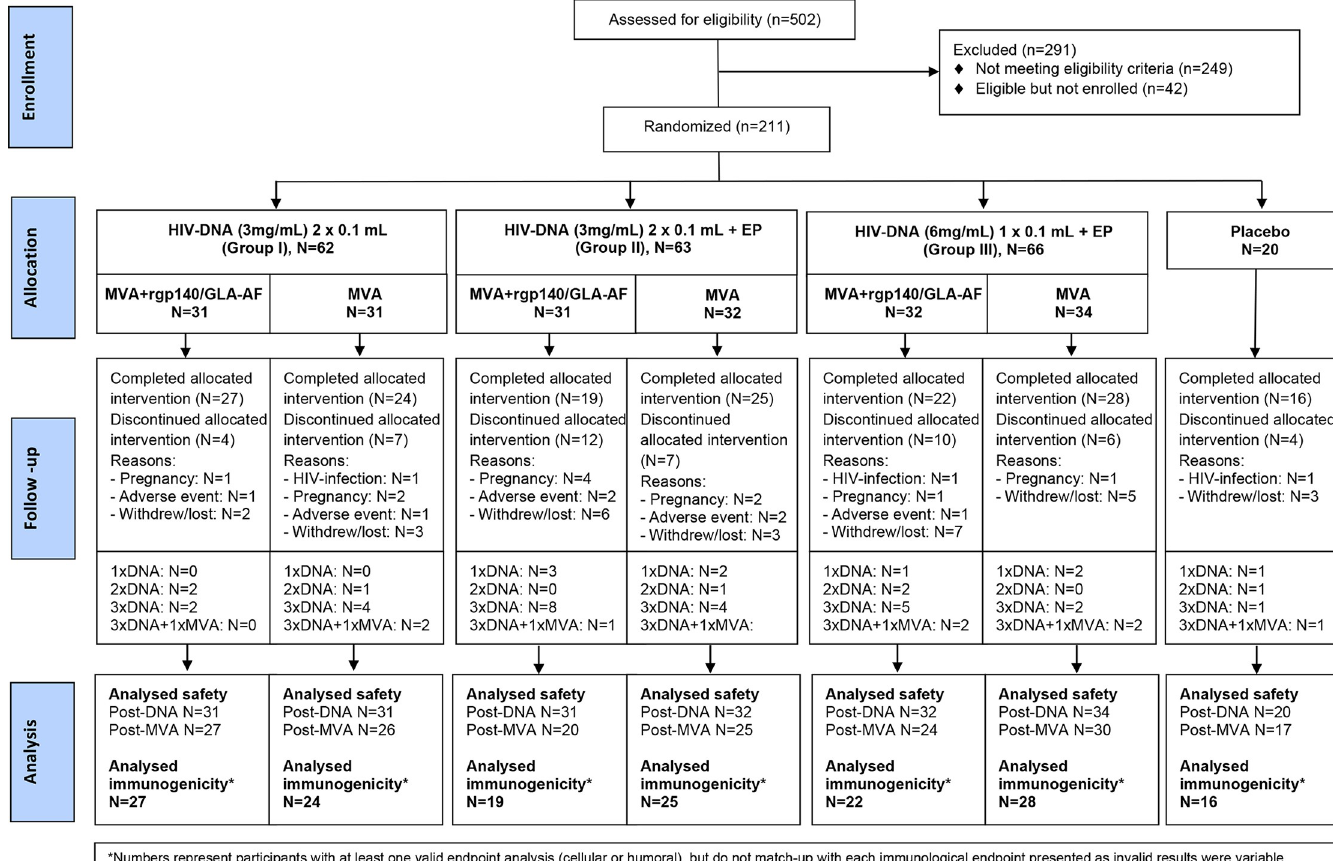
Fig 1. The number of individuals screened, randomized, allocated and withdrawn from the trial and the number of samples